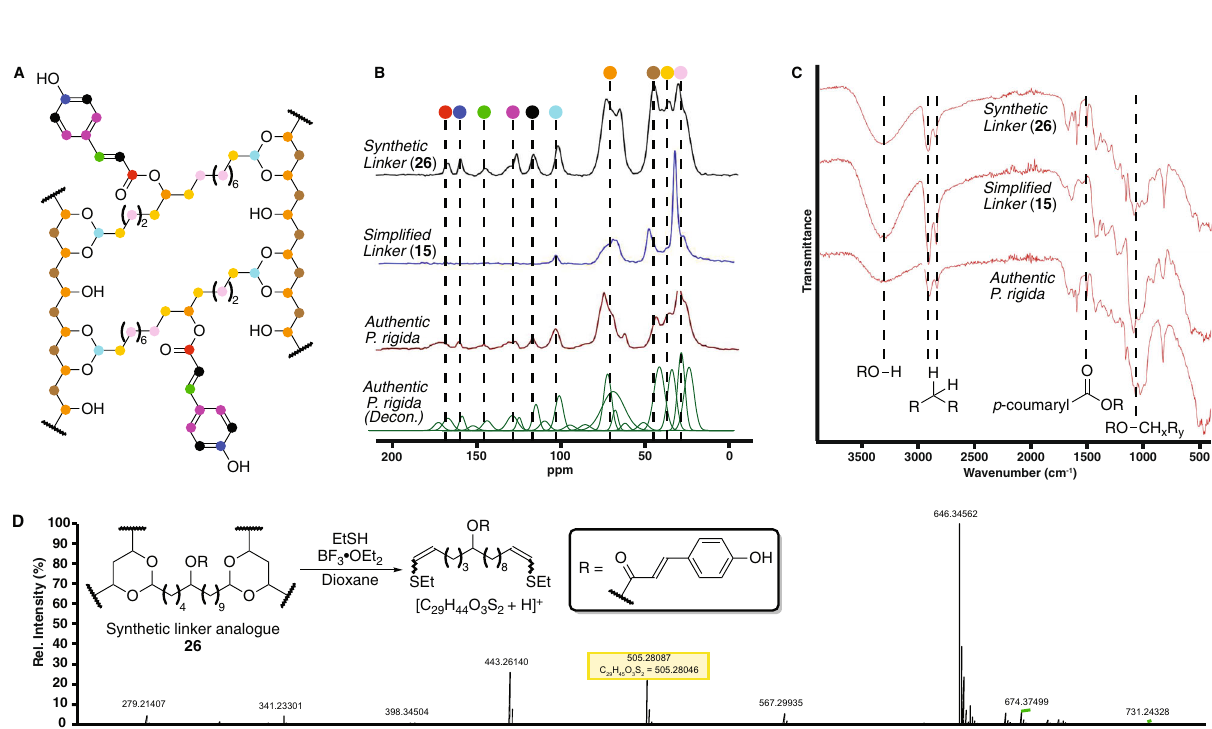
Fig. 3 Structural analyses of synthetic sporopollenin analogues. A Molecular structure of synthetic sporopollenin analogue 26 , B 13 C MAS ssNMR comparison (black: synthetic linker 26 analogue, blue: simpli fi ed linker 15 analogue, red: authentic P. rigida sporopollenin, green: computationally deconvoluted authentic P. rigida sporopollenin) 35 , C ATR-FTIR comparison (top: synthetic linker 26 analogue, middle: simpli fi ed linker 15 analogue,